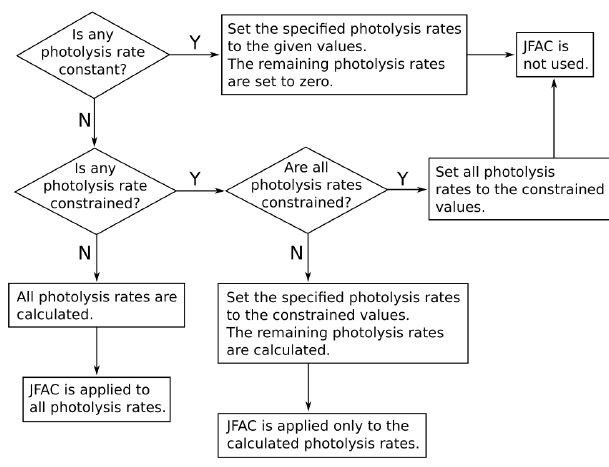
Figure 3. Treatment of photolysis rates in